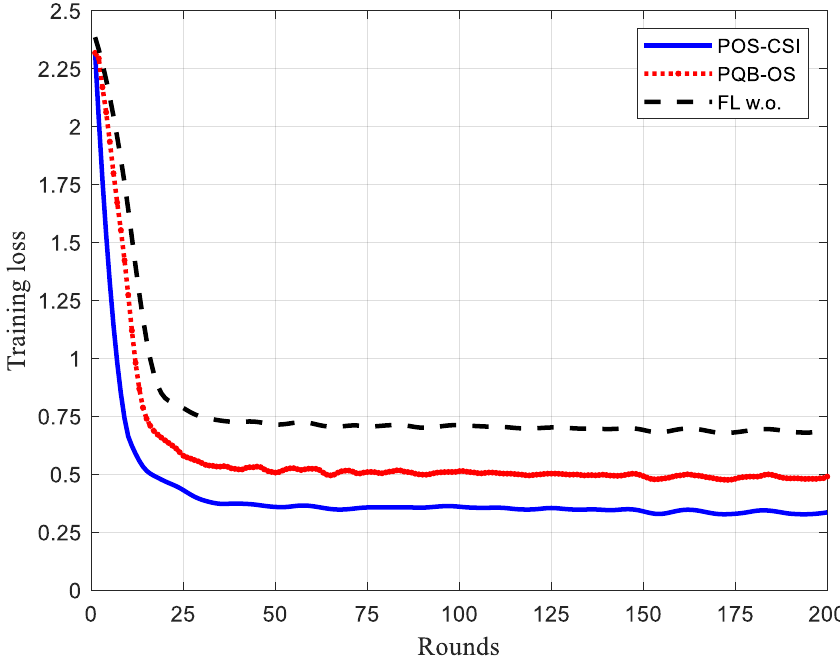
Figure 5. Training loss of proposed scheme and two benchmark schemes for MNIST dataset under non-IID distribution, when ∆ T = 50 s, B n = 1 MHz, P n = 0.5 W, and D n =